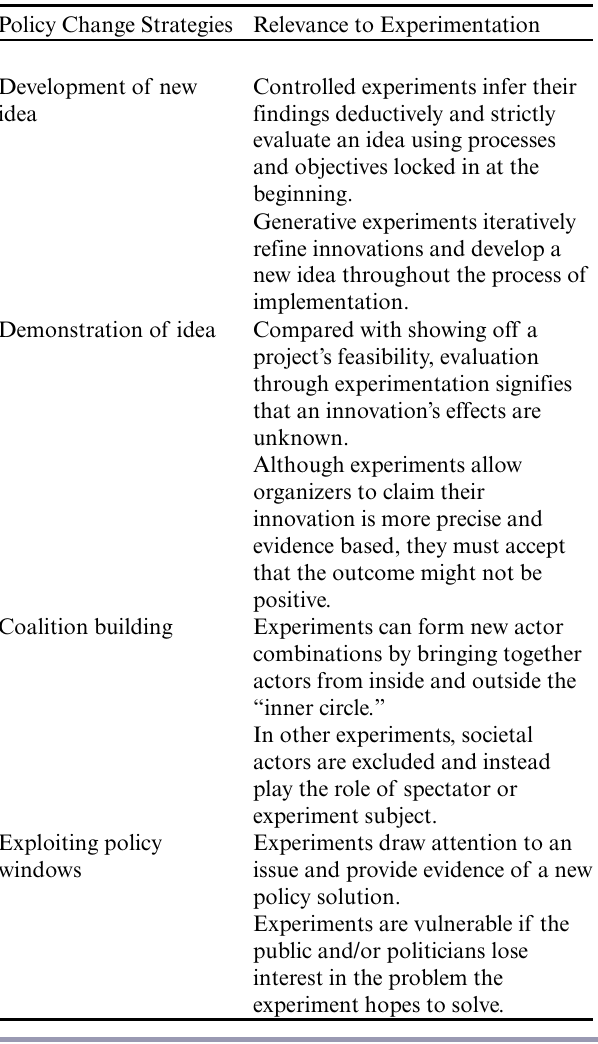
Table 1 . Summary of the ways policy experiments relate to different policy change